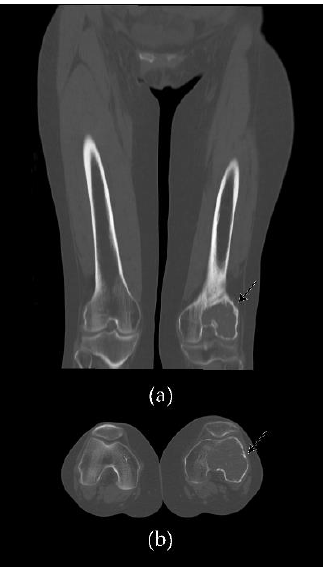
Figure 2. Comparative CT scan of a case of GCTB of the lateral condyle of the left femur: ( a ) coronal and ( b ) axial views demonstrate an extensive osteolytic lesion with cortical thinning (arrows). Note the osteo-structural alteration with a loss of bone trabeculation in comparison with the contralateral right normal limb.